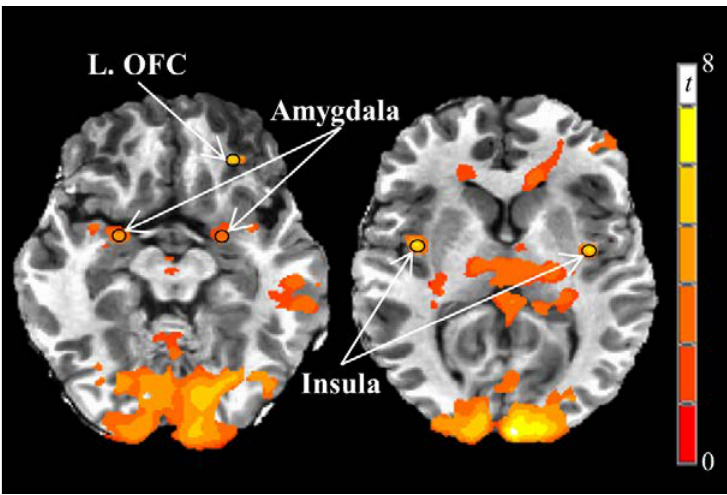
Figure 5. Fasting-state neural responses to visual food stimuli on Day 1. Greater responses to visual food stimuli vs. nonfood stimuli (PROC TTEST, SAS, Version 9.3; p < 0.005) were observed in the bilateral insula and amygdala and left orbitofrontal cortex. Black circles represent functional regions of interest with 3 mm radii within a priori brain regions of interest with known reward functions. Images are in the axial plane and left side of the figure corresponds to the right side of the body and vice versa . Display threshold: p < 0.001 (uncorrected), minimum cluster size of 250 voxels. Abbreviations: OFC, orbitofrontal